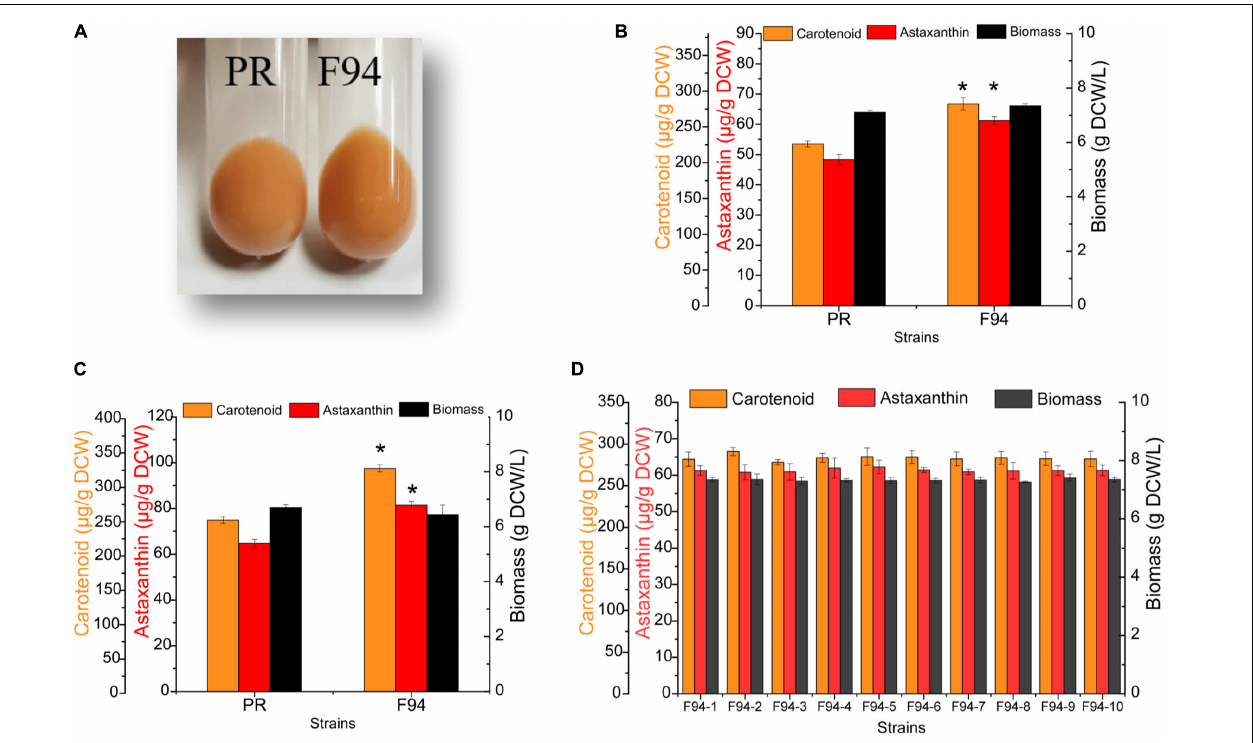
FIGURE 2 | Analysis of growth performance, carotenoid synthesis ability, and stability of mutagenized strains. (A) Comparison of the color of PR and F94 strains. (B) Analysis of growth and pigment content of PR and F94 strains in YPD medium. (C) Analysis of growth and pigment content of PR and F94 strains in Yeast Malt Agar (YM) medium. (D) Stability analysis of F94 strain. Statistical analysis was performed using Student’s t -test (* p < 0.05).